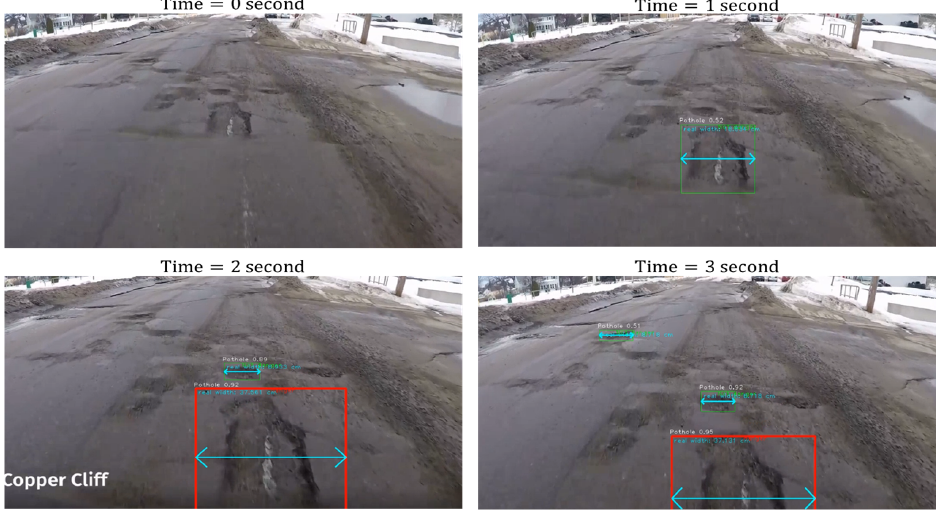
Figure 13. Risk assessment through detected pothole using SPFPN-YOLOv4 tiny.